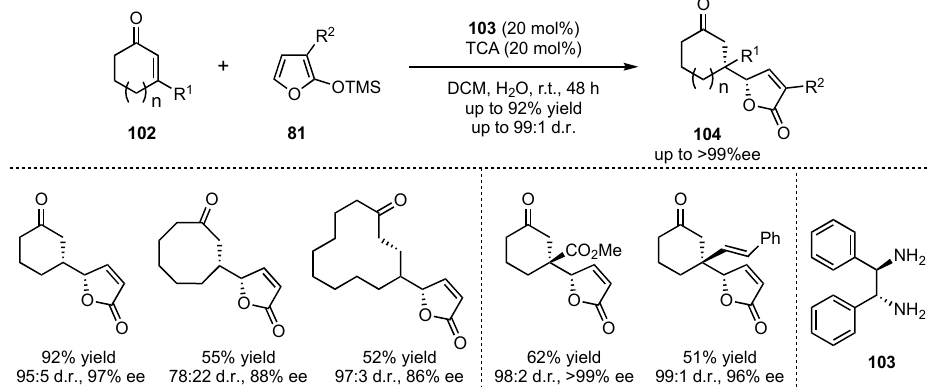
Scheme 25. Amplification of the chiral amine catalyzed VMMcR toward cyclic enone-substrates